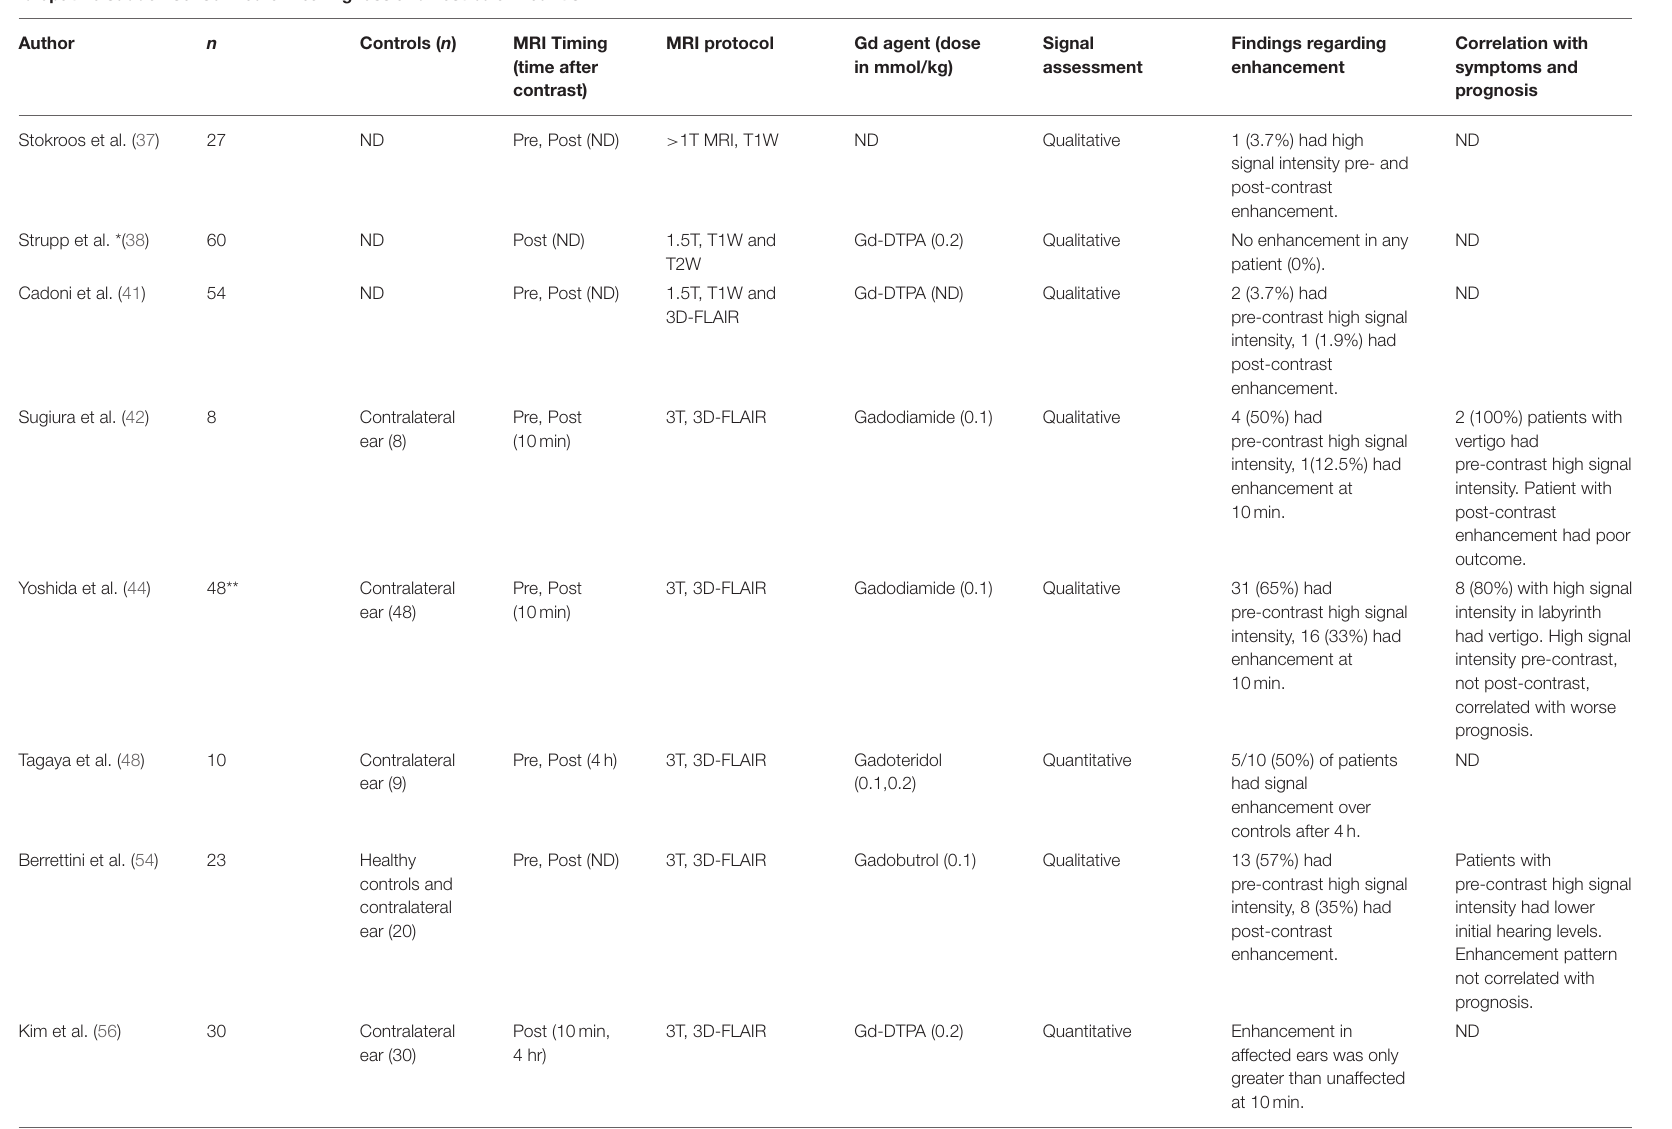
TABLE 3 | Summary of findings in studies of idiopathic sudden sensorineural hearing loss and vestibular